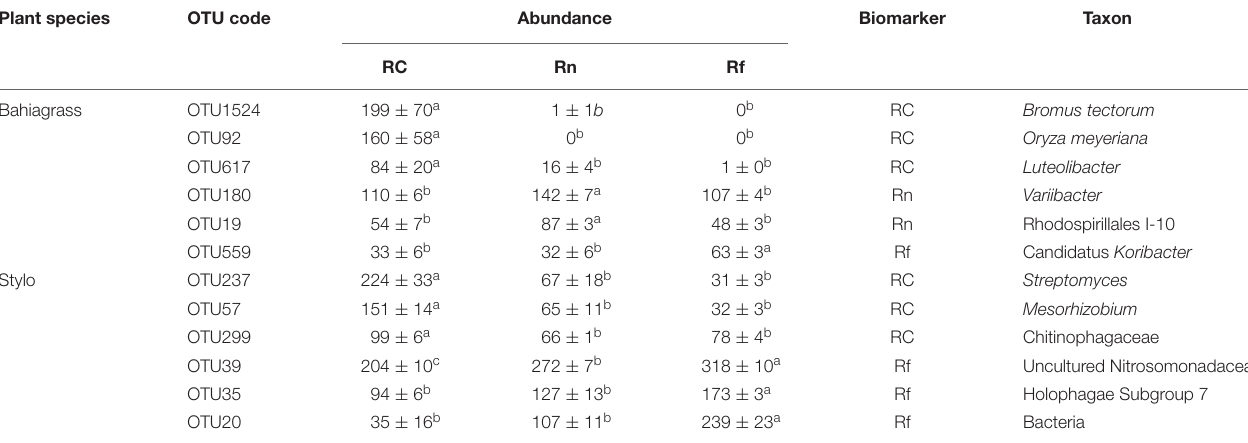
TABLE 3 | Biomarkers of different distance in the rhizosphere of two plant species as revealed by soil bacteria (OTUs) enriched.